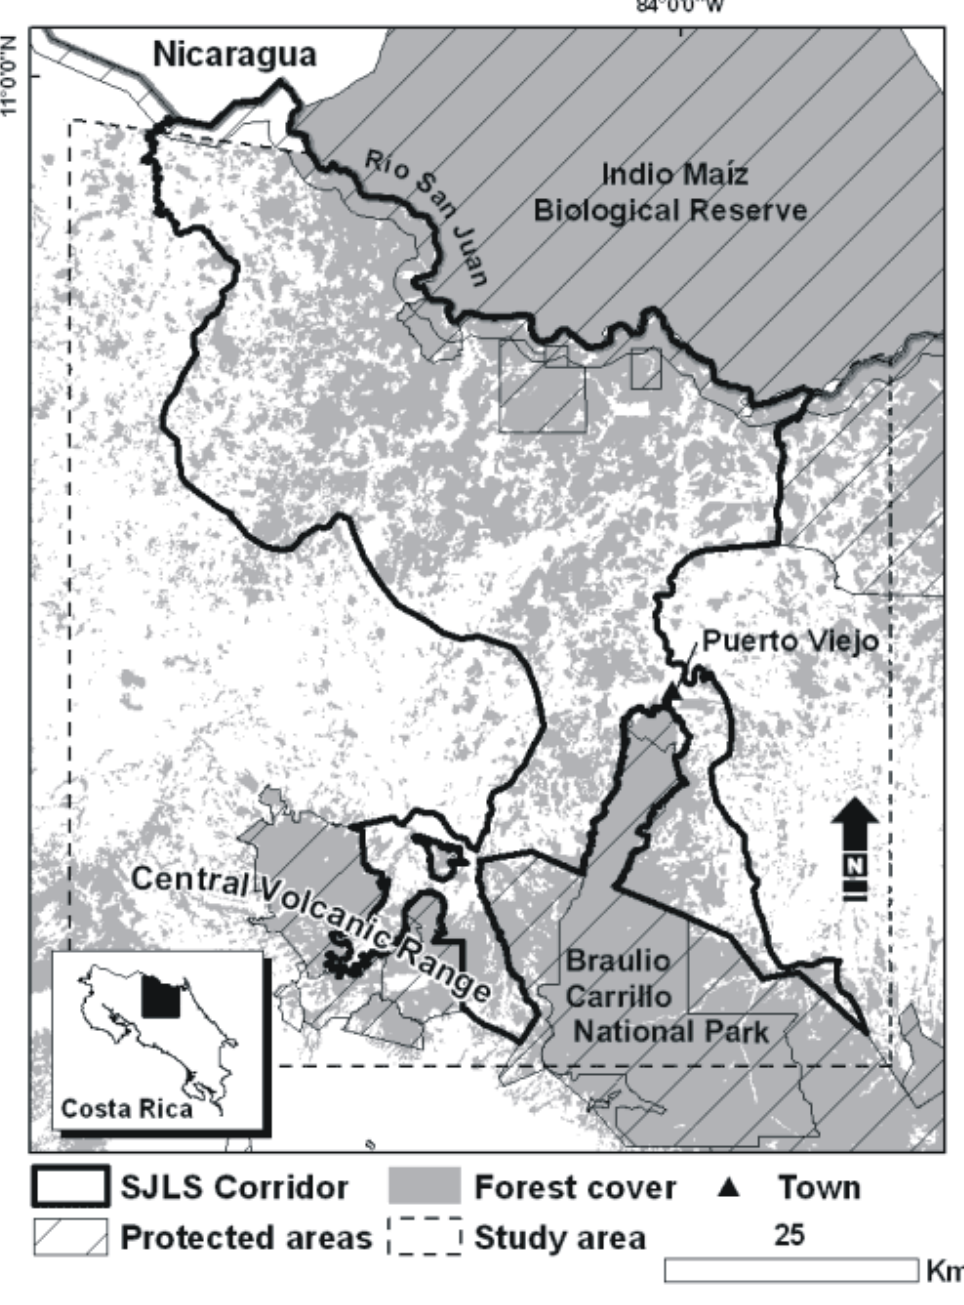
Fig. 1 . Map of the San Juan-La Selva (SJLS) Biological Corridor. Depicted natural forest cover is for year 2000 (ITCR